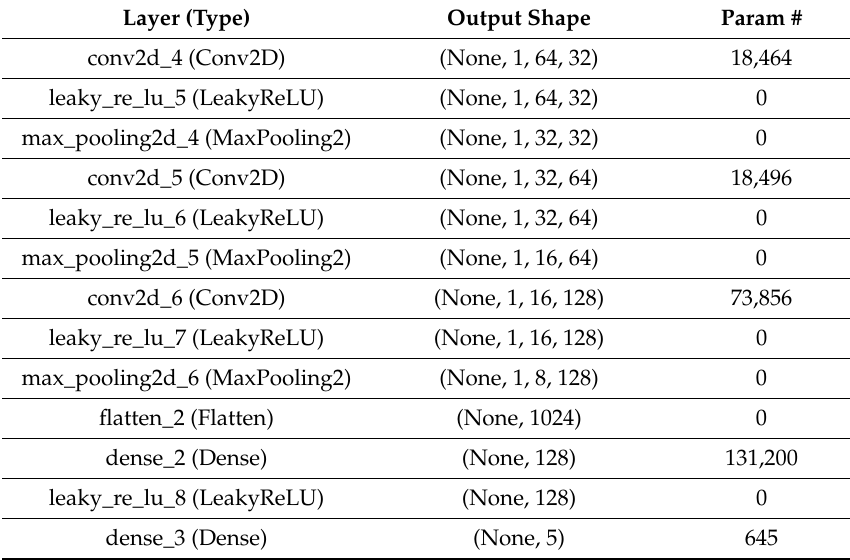
Figure 6. The proposed deep convolutional neural network architecture diagram. The RP images are resized to 64 × 64 and fed as input to the CNN model. The architecture consists of one input and two hidden layers followed by pooling layers and a fully connected layer. Table 1. Proposed CNN model